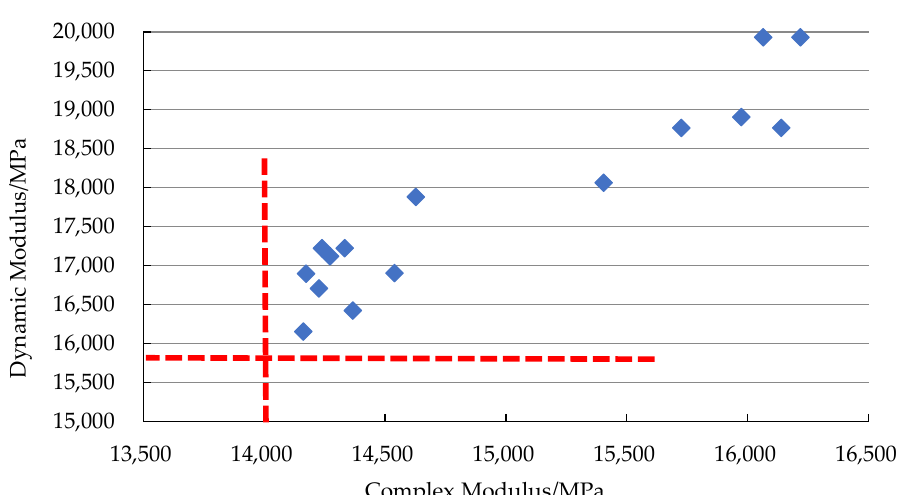
Figure 11. Corresponding relationship of modulus at 15 °C, 10 Hz.